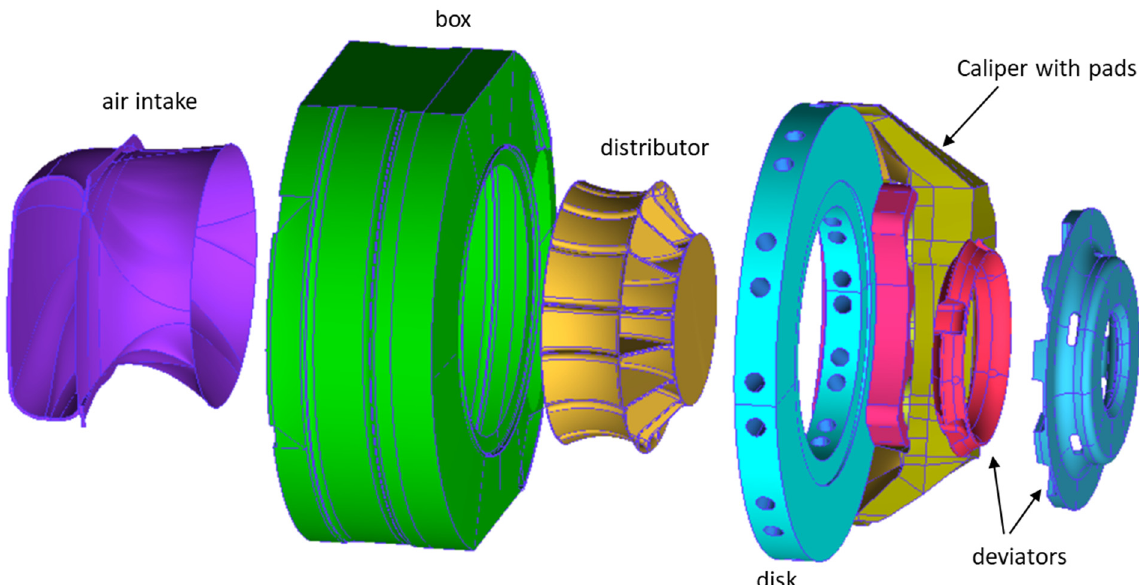
Figure 2. Expanded view of internal components of the disk brake assembly.